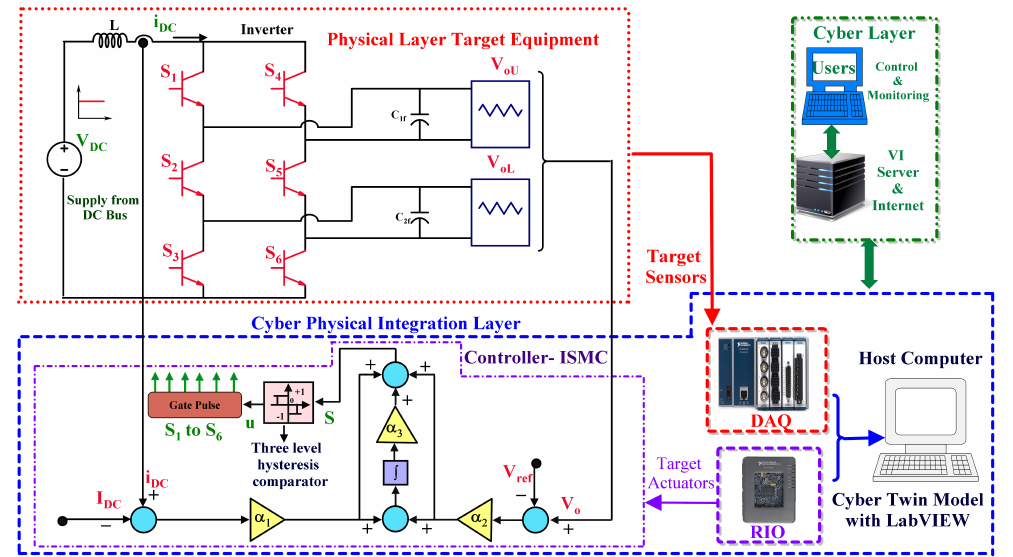
Figure 2. System